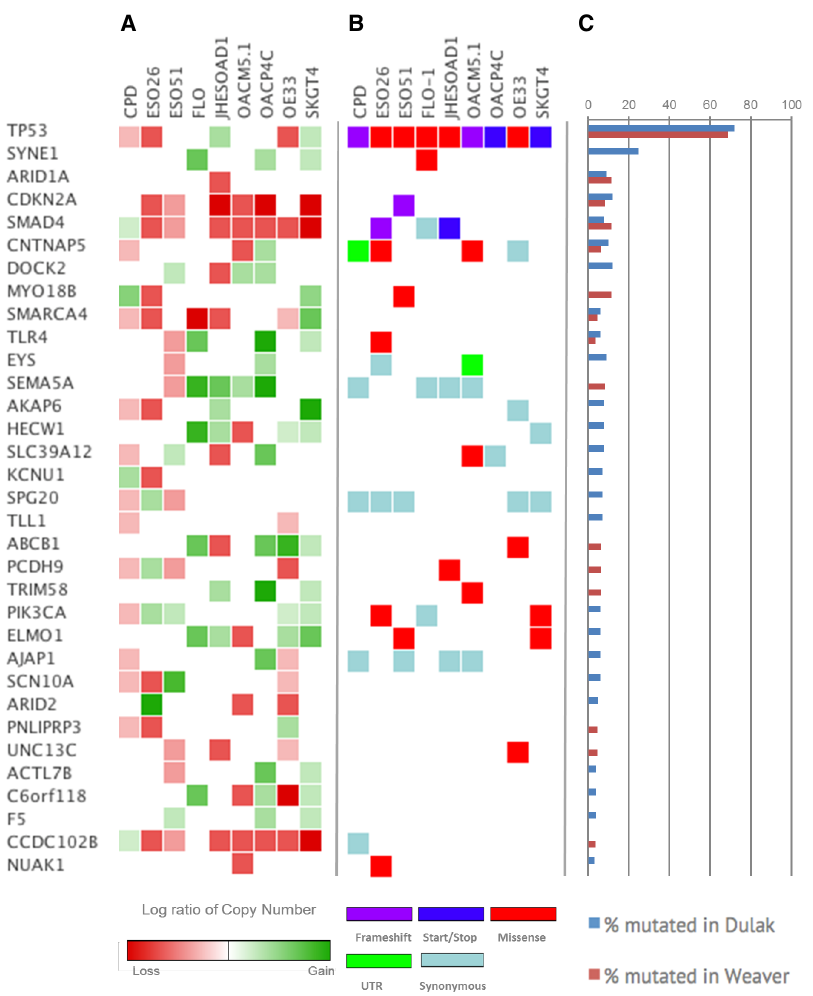
Figure 2. Analysis SNV and CNA of putative EAC genes identified in Dulak et al. (2013) and Weaver et al. (2014). A ) Log ratio of copy number status of the selected genes computed with Control-Freec (green indicates CN gain and red CN loss). Genome wide CN for each line is available in Supplementary material 1 and Supplementary material 3. B ) SNVs identified by our pipelines and annotated by Variant Effect Predictor analysis (Ensembl). When more than one variant was present in a single gene, the most deleterious was annotated according to the color-coded legend reported at the bottom of the figure. A complete annotation of identified SNV are available in the Supplementary material 2. C ) Blue and red bars indicate the mutation rate of EAC genes reported in Dulak et al., 2013; and Weaver et al. , 2014,